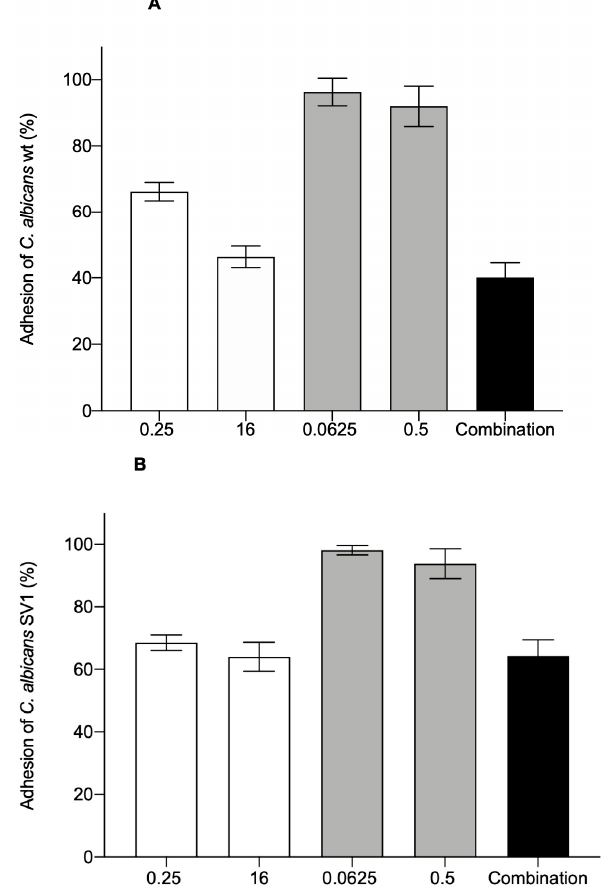
Figure 1. Adhesion of C. albicans wt ( A ) and SV1 ( B ) yeasts to the surface of HEK-293 cells. Cells were treated with different concentrations ( μ g/mL) of CSDP + (white bars), fluconazole (grey bars), and their combination (0.25 μ g/mL of CSDP + and 0.0625 μ g/mL of fluconazole, black bars). Data are shown as mean ± standard deviation (SD). In the absence of any compounds, 100% adhesion was registered.